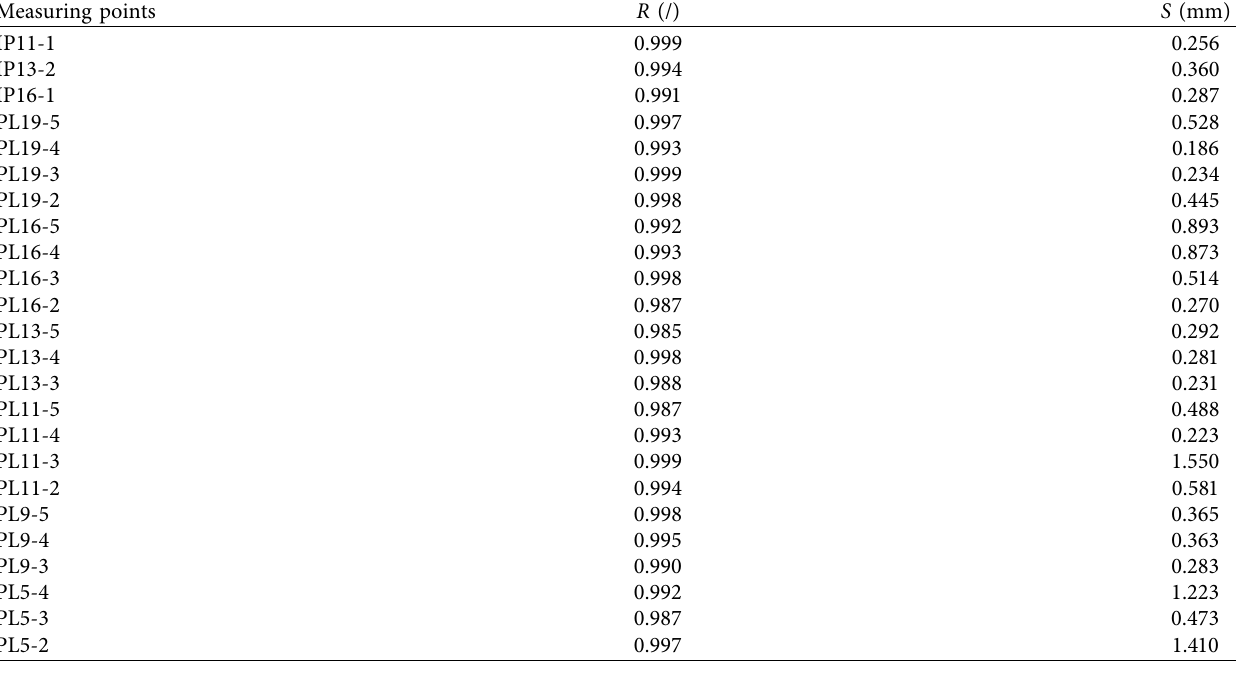
Table 5: Correlation coefficient R and residual standard deviation s of the synthetic model for each monitoring point.